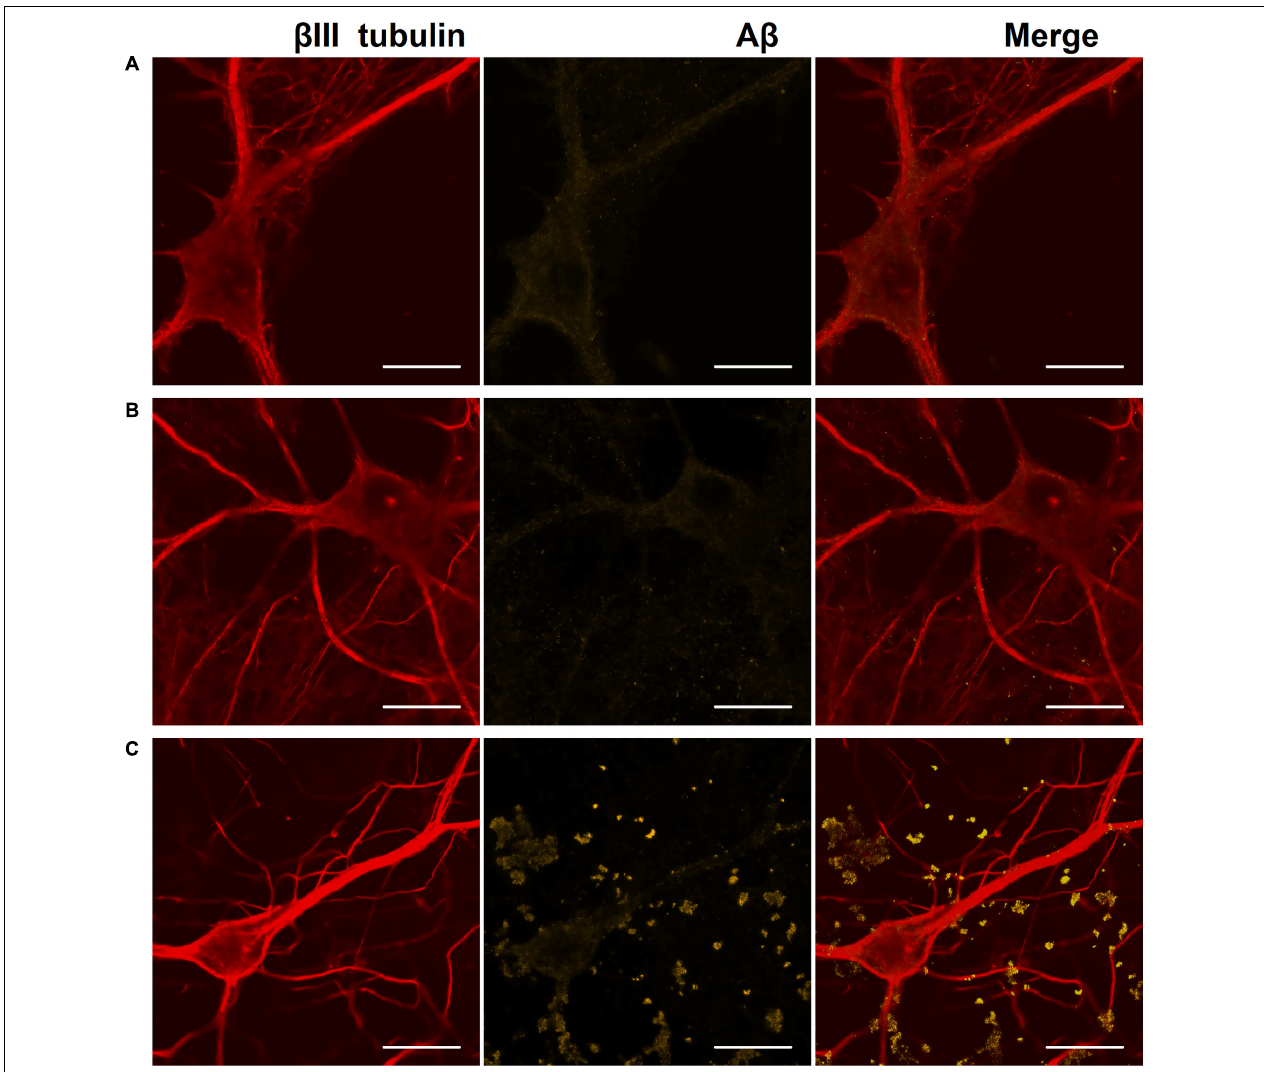
FIGURE 6 | Representative confocal images of immunocytochemical staining of primary hippocampal cultures on DIV 28. (A) Sham culture, (B) primary culture with single A β application, (C) primary culture with chronic A β application. Red: fluorescence channel of β III tubulin (neuronal microtubule marker); yellow: fluorescence channel of A β . Scale bar – 20 µ m. A significant amount of A β associated with cells as protein globules was detected only in cultures with chronic A β